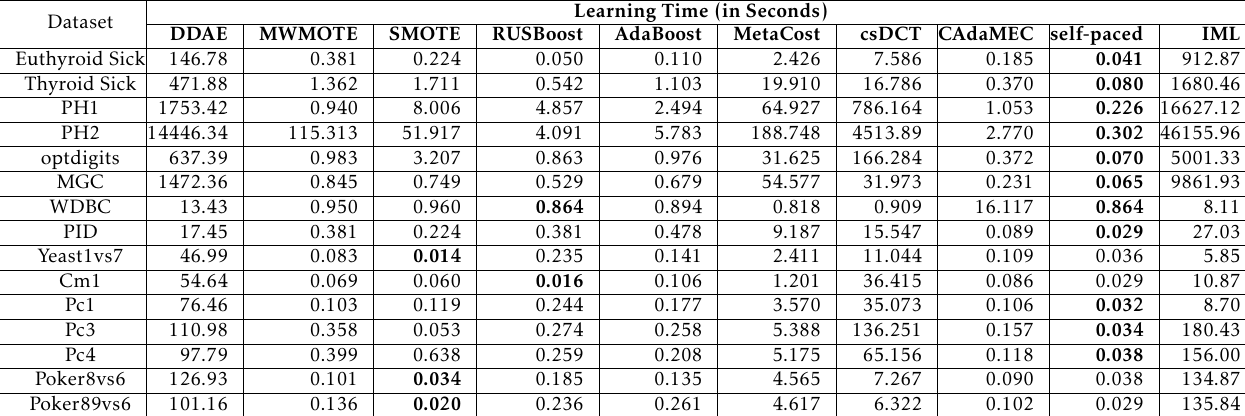
Table 23. Learning Time for All Models on the Public Datasets